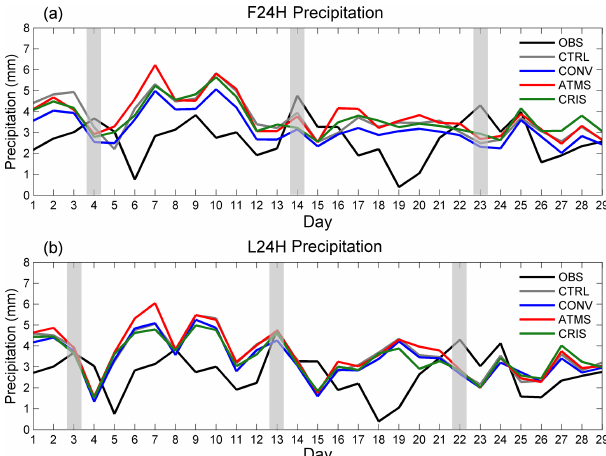
Figure 8. Time series of daily precipitation distribution for (a) F24H forecast and (b) L24H forecast. The black, grey, blue, red, and green lines indicate for observation, CTRL, CONV, ATMS, and CRIS, respectively. The unit is mm. The grey shadings indicate the underestimated